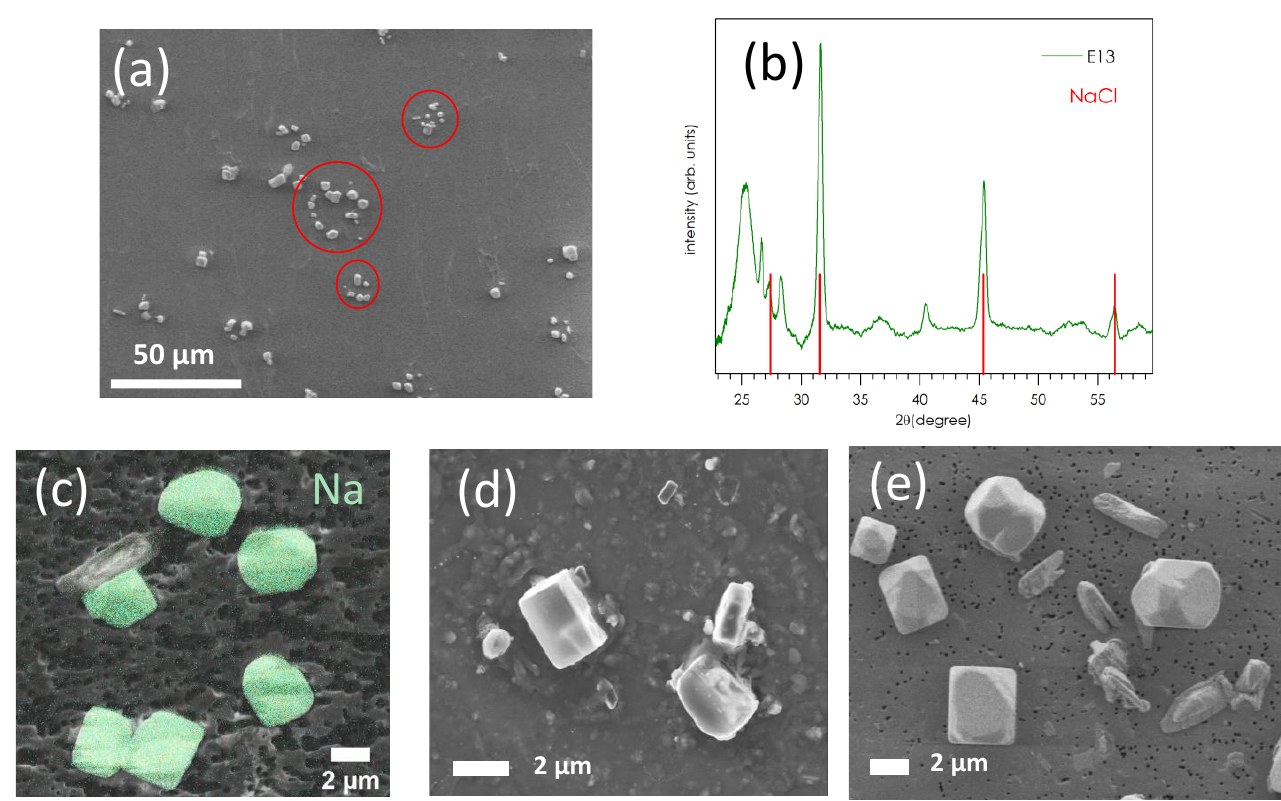
Figure 4. ( a ) SEM image at low magnification of stage E13 (D50% = 9.97 µm) of the P1 sample from Porquerolles (March 2019). ( b ) XRD spectrum of E13-P1; angular positions of NaCl diffraction lines are indicated by red lines. ( c ) SEM image coupled with EDX analysis of sodium of E13-P1. SEM images of ( d ) stage E13 of the P2 sample of Porquerolles (July 2019) and ( e ) stage E13 of the C4 sample from Le Croisic (July 2020), showing similar NaCl crystallites .